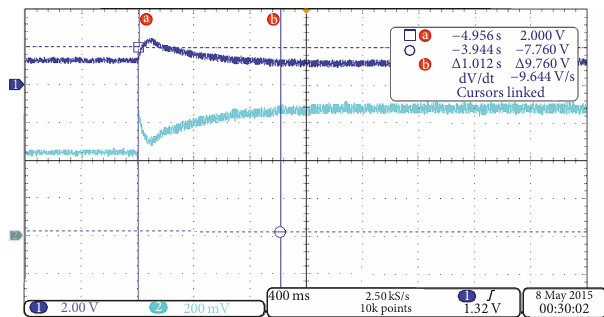
Figure 15: Input voltage trace 1 [200V/Div.] and input current in trace 2 [10A/Div.] at connecting the additional